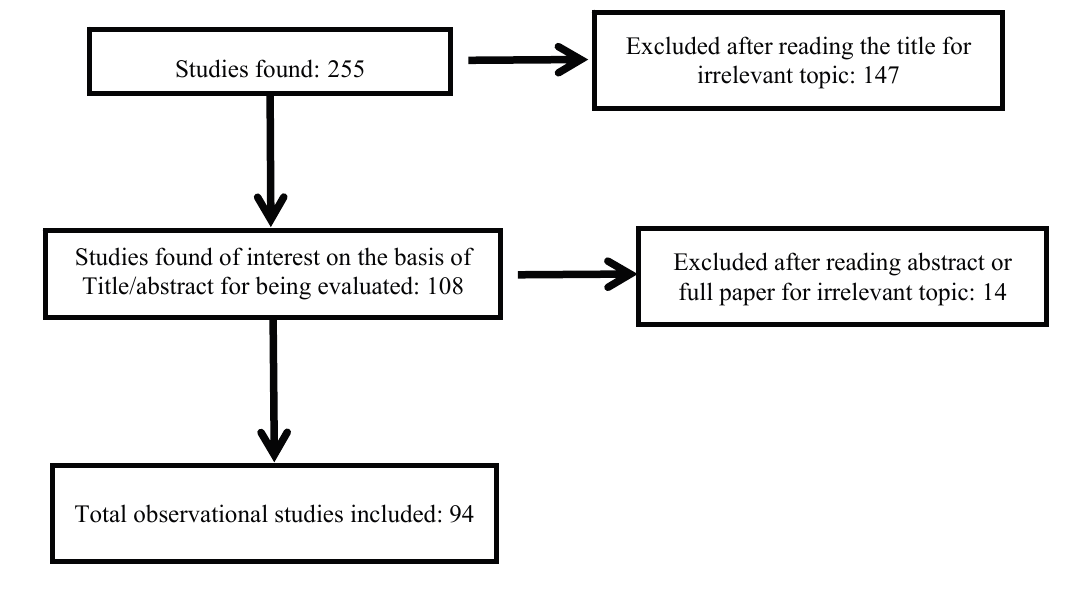
Figure 1. Flow diagram of study selection